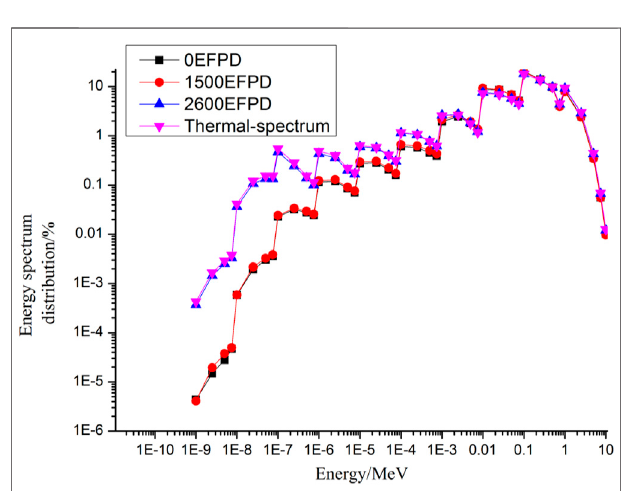
FIGURE10| Energyspectrumresultsofthespectral-shiftschemeinthe SLBR-50.